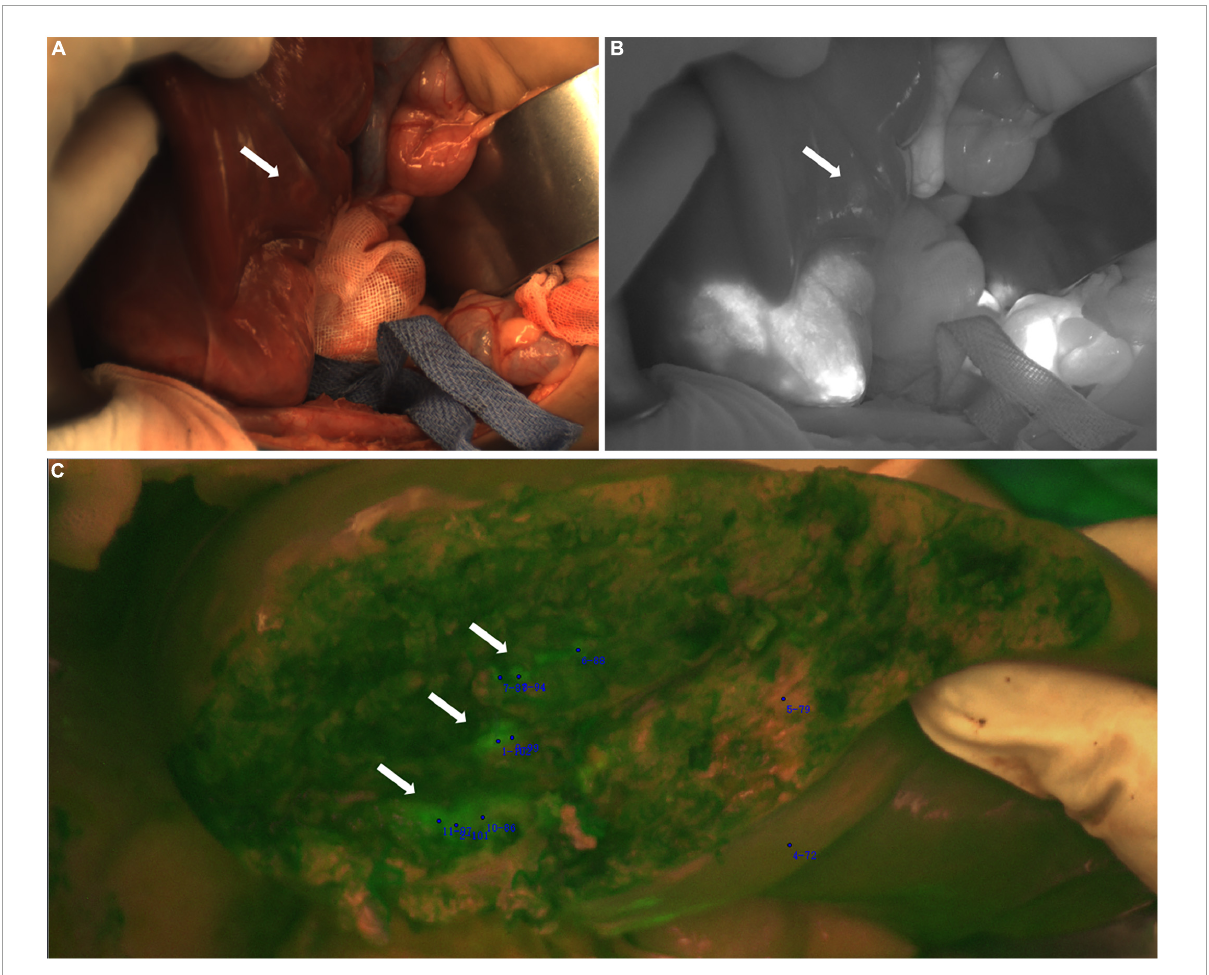
FIGURE6 Case 4. Near infrared photography of ICG ( − ) and ICG (+) lesions during operation. (A,B) The white arrow refers to the white light and fluorescence images of suspicious lesions, ICG ( − ). (C) In the fusion image of the resection stump of the residual liver, the white arrow points to 3 ICG (+) regions,